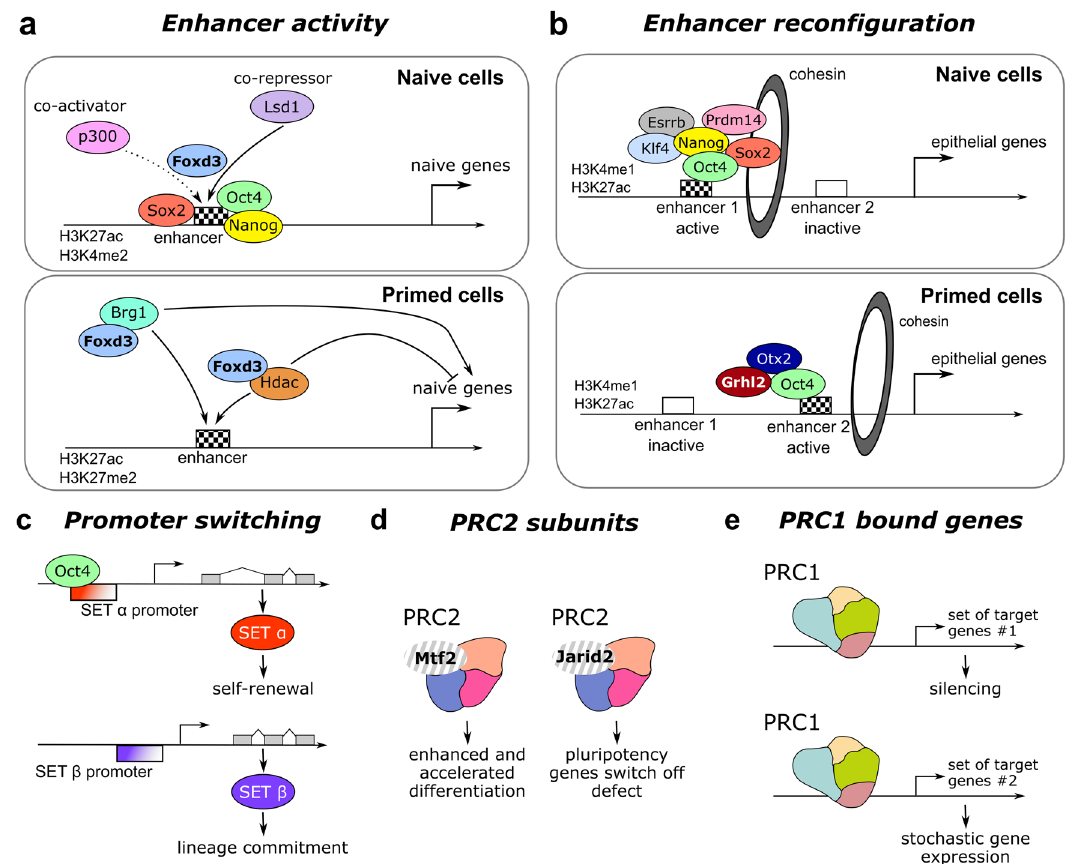
Fig. 4 | Molecular Versatility of epigenetic mechanisms. a The activity of enhancersiscontrolledbytheversatileactionsoftheFoxD3transcriptionfactor.In naïve cells, FoxD3 actasa repressor thatdecommissions active enhancersof naïve pluripotency genes. In primed cells, FoxD3 exerts dual functions by initiating enhancer activityby recruiting Brg1whilesimultaneously repressing theirmaximal activation by recruiting histone deacetylases, illustrating its molecular versatility. b The TF Grhl2 orchestrates an enhancer switching program during pluripotency progression. Grhl2 partitions the pluripotencynetwork and sustain the expression